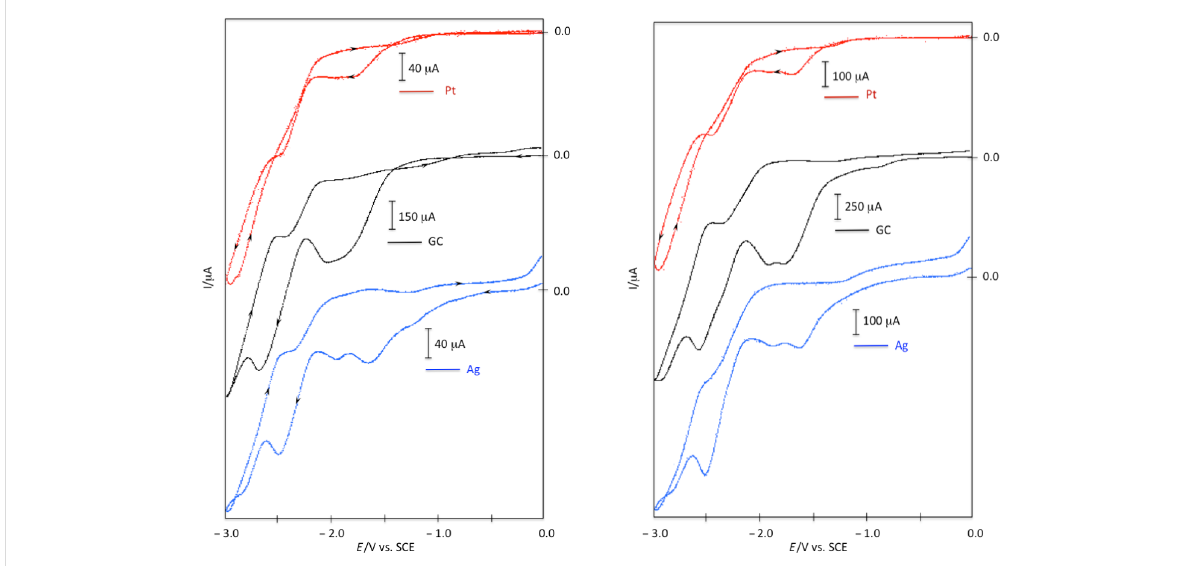
Figure 1: Voltammetric curves of 1a 0.020 mol dm − 3 ; Pt, glassy carbon (GC) or Ag cathode. ν = 0.2 V s − 1 , T = 25 °C; solvent left: DMF/Et 4 NBF 4 0.1 mol dm − 3 ; right: ACN/Et 4 NBF 4 0.1 mol dm − 3